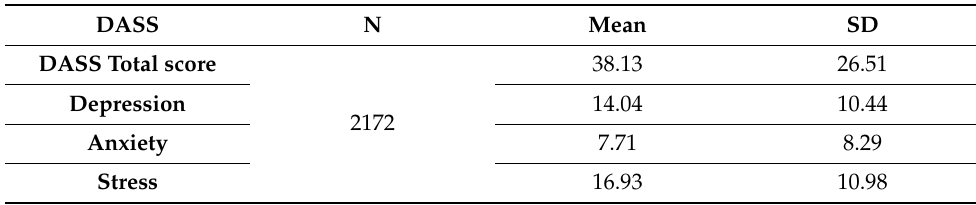
Table 2. Results of depression, anxiety, and stress severity for the whole group based on the DASS- 21 scale. DASS